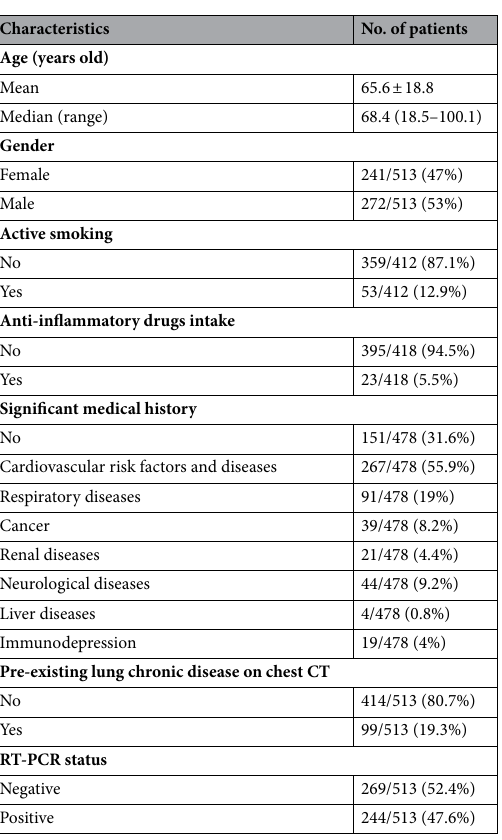
Table 1. Characteristics of the study population. Note Data refer to the number of patients with percentage in parentheses, except for